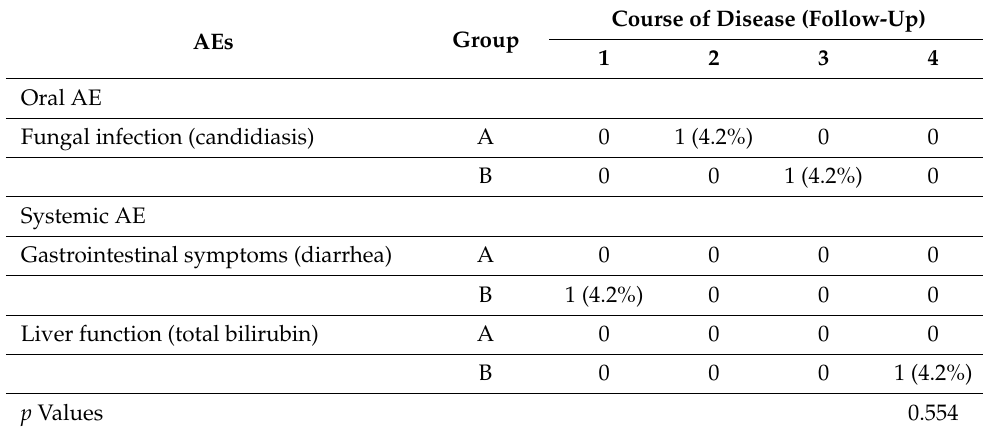
Table 7. Adverse events (AEs) in both groups with certain or possible causal relationships to the applied drugs